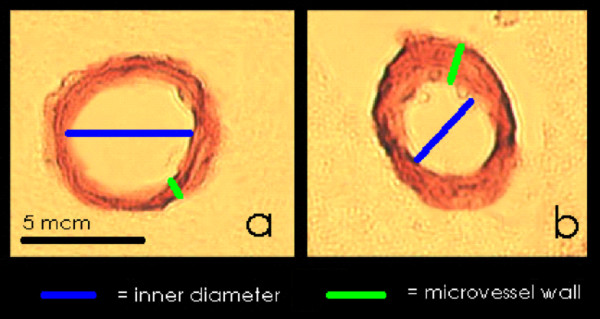
Analysis of the thickness of the vessel wall and the inner diameter of the vessel lumen in YP and OP. Figure A indicates YP, Figure B indicates OP.